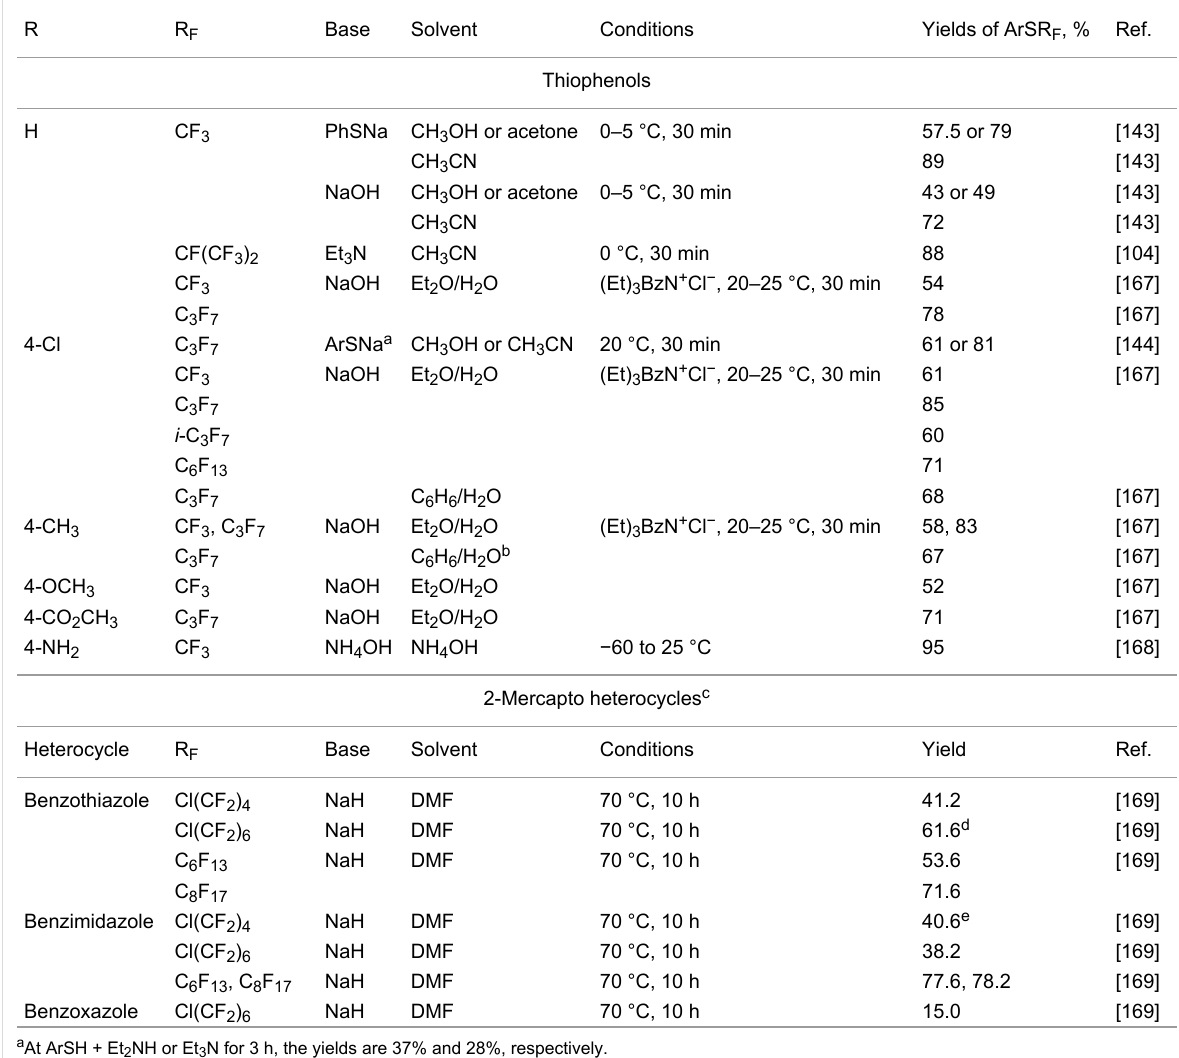
Table 4: Reaction of thiophenols RC 6 H 4 SH and mercapto heterocycles with R F I under UV irradiation in organic solvents and biphasic conditions.